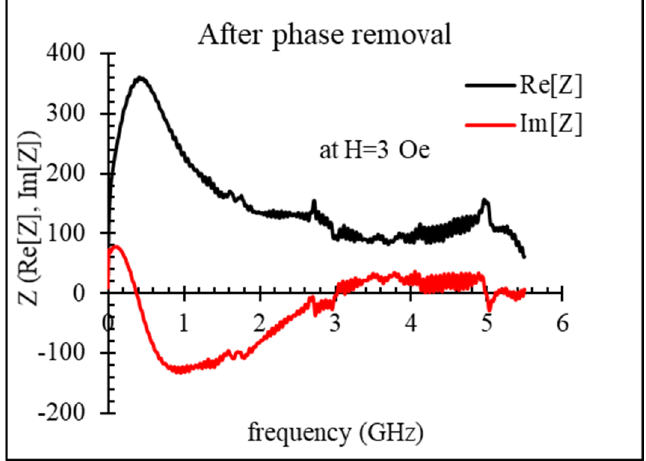
Figure 5. Dispersions of the impedance of amorphous Co 71 Fe 5 B 11 Si 10 Cr 3 microwire (sample No2, as-cast) obtained from using user’s ideal calibration kit created on VNA after phase compensation. The parasitic resonances observed between 5 and 6 GHz were introduced during the SOLT calibration and were caused by the PCB cell and connection lines. These resonances are well localized and can be easily replaced with smooth